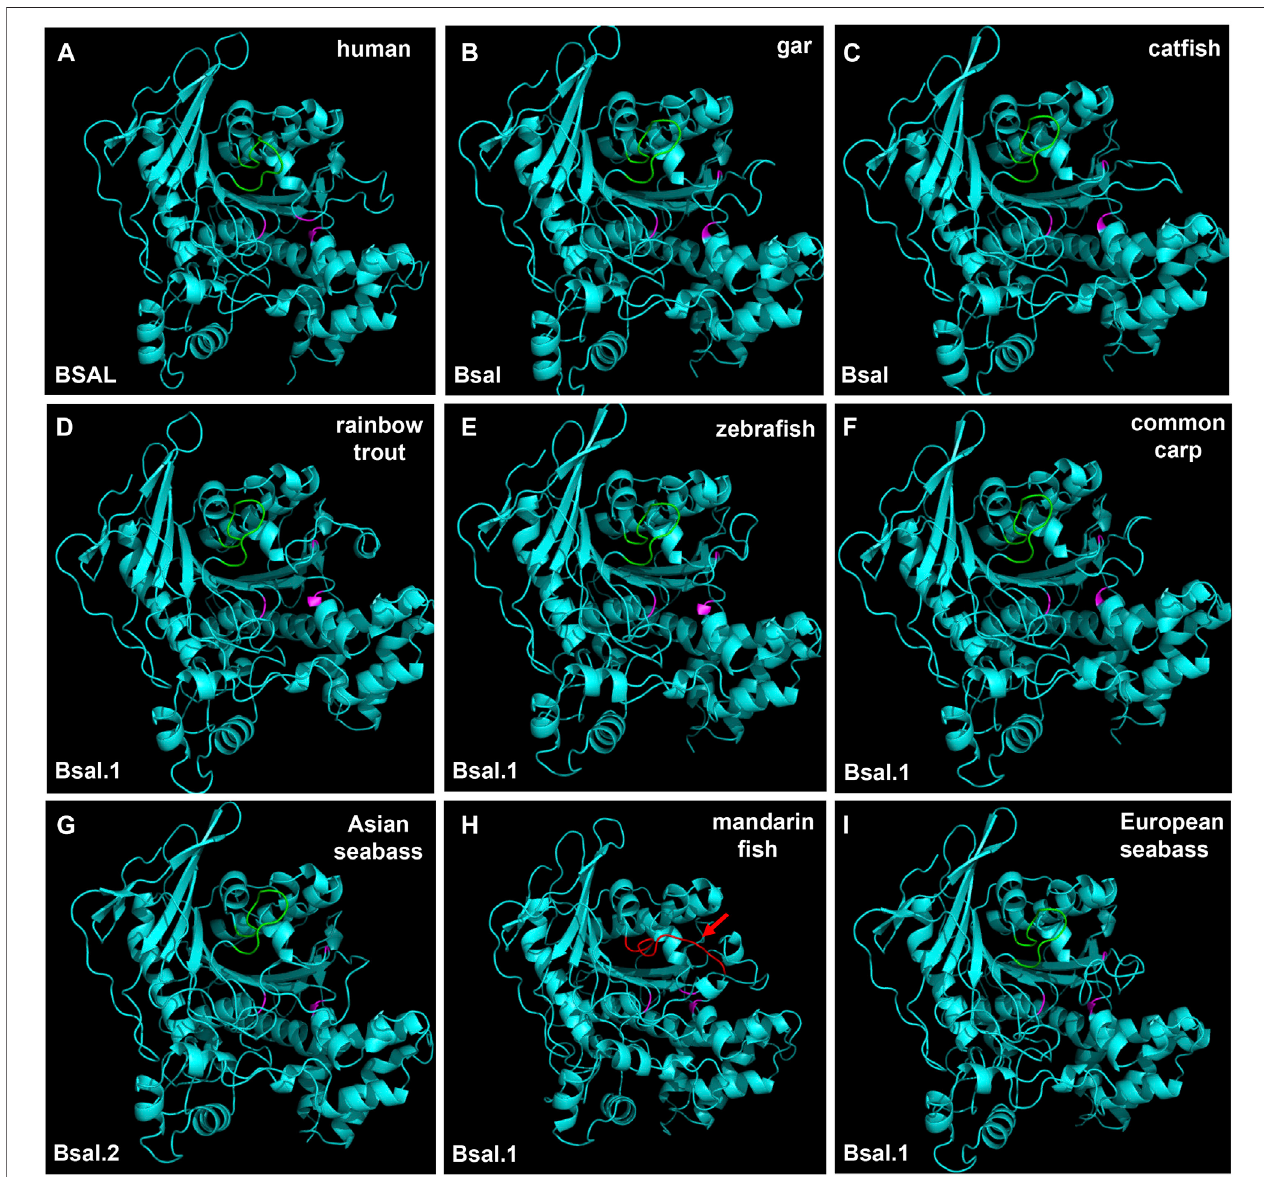
FIGURE 8 | 3D structures of bile salt-activated lipases in human and partial fi sh species. The region of amino acid residues in the bile salt-binding site (GANFLXNYLY)wasmarkedwithgreen.ActivesitetriadresiduesSer,Asp,andHisweremarkedwithpink.Theredarrowrepresentsthenoloopstructurethatexistedin mandarin fi sh (H)